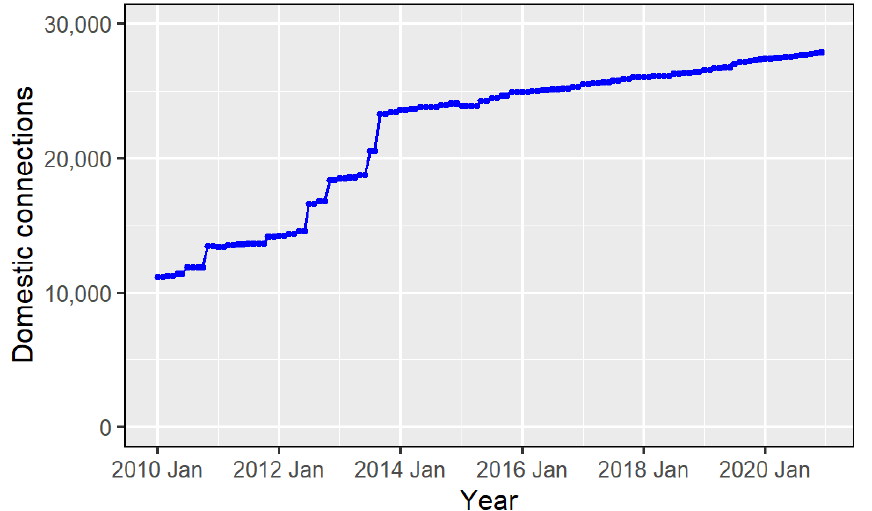
Figure A1. Time-series of domestic connections in Tajpura.